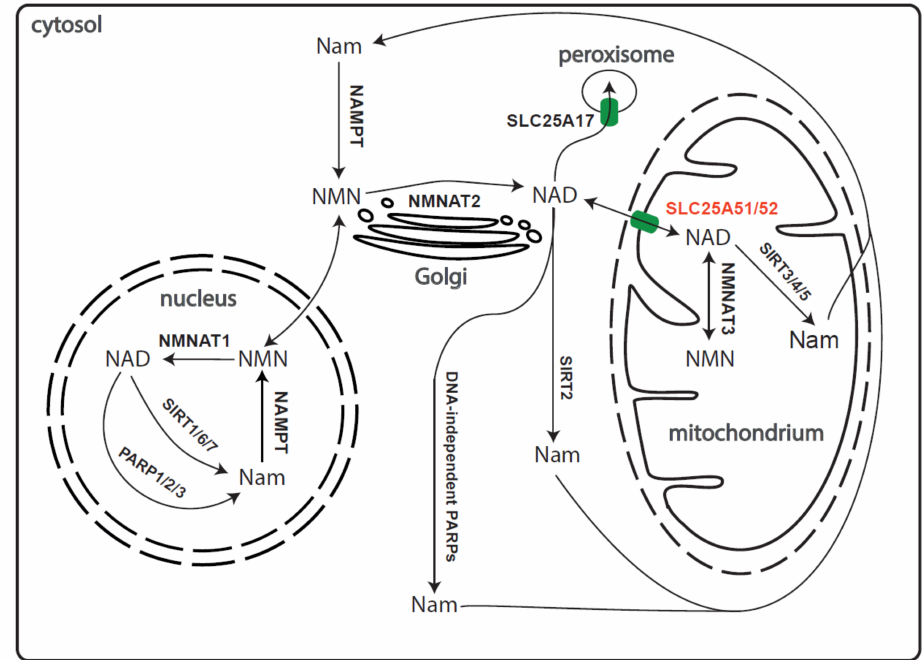
Figure 1. Compartmentalisation of NAD + biosynthesis and salvage pathway in human cells. The fig- ure shows the compartmentalisation of NAD + synthesis, consumption, and salvage. The three different isoforms of NMNAT show distinct subcellular localisations with NMNAT1 primarily local- ized to the nucleus, NMNAT2 localized to the Golgi apparatus, and NMNAT3 in the mitochondria. The peroxisomal and mitochondrial SLC transporters are highlighted in green. (Abbrev.: Nam: nicoti- namide; NMN: nicotinamide mononucleotide; NMNAT1/2/3: NMN adenylyltransferase 1/2/3; SIRT: sirtuin; PARP: poly-ADP-ribosyl polymerase; NAMPT: Nam